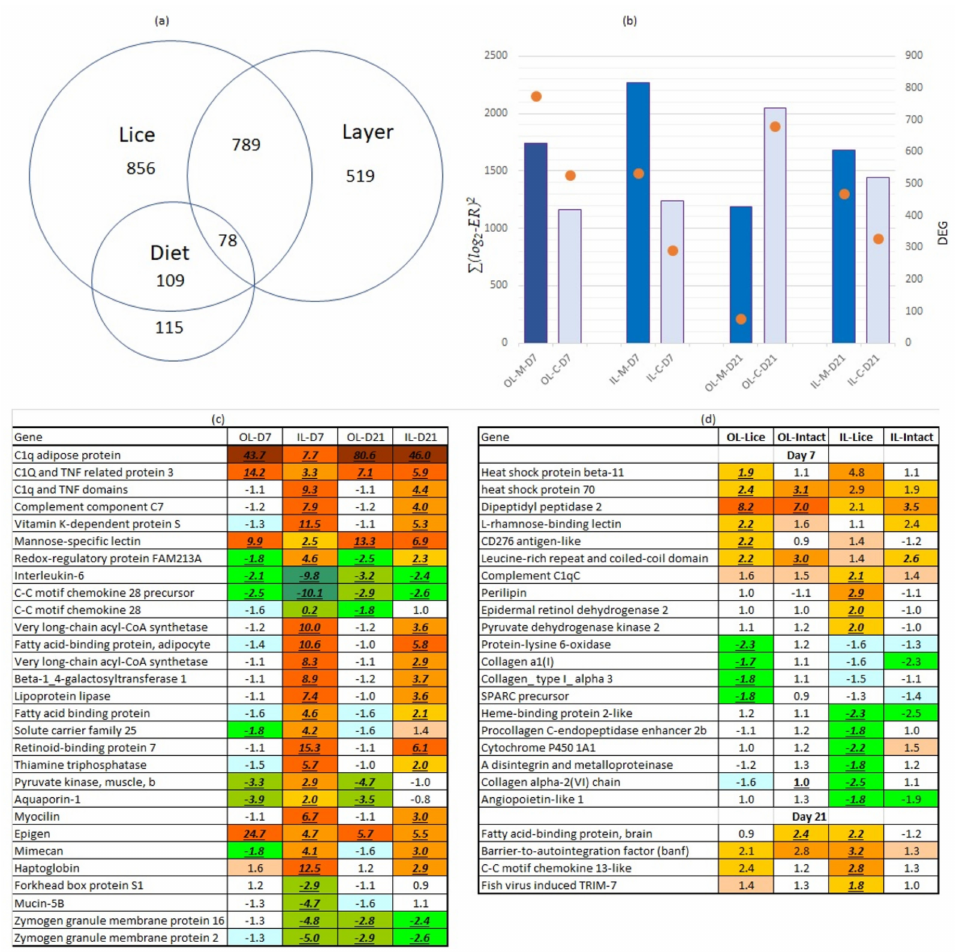
Figure 3. Summary of transcriptome analyses ( a ) Venn diagram: numbers of genes that showed responses to lice, the difference between the skin layers, and diets in at least one comparison. ( b ) The magnitude of responses to lice assessed as ∑ (log 2 -ER) 2 (bars, left axis) and numbers of DEG (orange circles, right axis). ( c ) Genes with stronger responses to salmon louse in outer and inner skin layer at 7 dpc and 21 dpc. Data are expression ratios (folds) to intact skin (means for both diets), significant differences are indicated with underlined italic bold. ( d ) Effect of mineral supplementation on gene expression in outer and inner skin layer 7 dpc and 21 dpc. Data are expression ratios (folds) of salmon fed with M- and C-diets in lice infected (L) and intact skin (means for both diets), significant differences are indicated with underlined italic bold. Abbreviations: OL, IL—outer and inner layers, M, C—diets, D—days post-challenge. Red and green color in (c) and (d) denote up and down-regulation of the